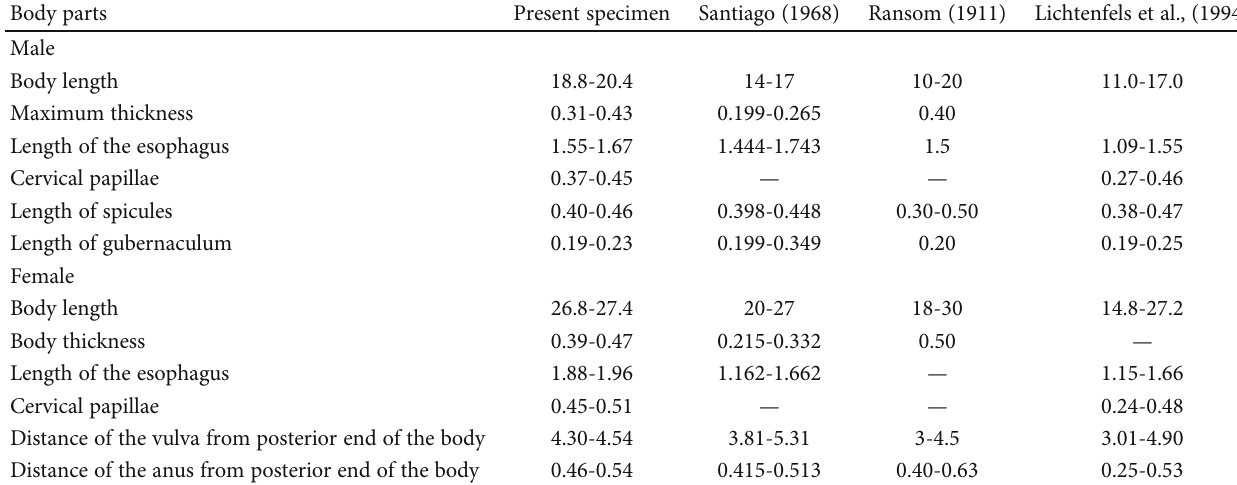
Table 3: Comparative measurement (in mm) of present Haemonchus contortus isolated and those previously recorded. Body parts